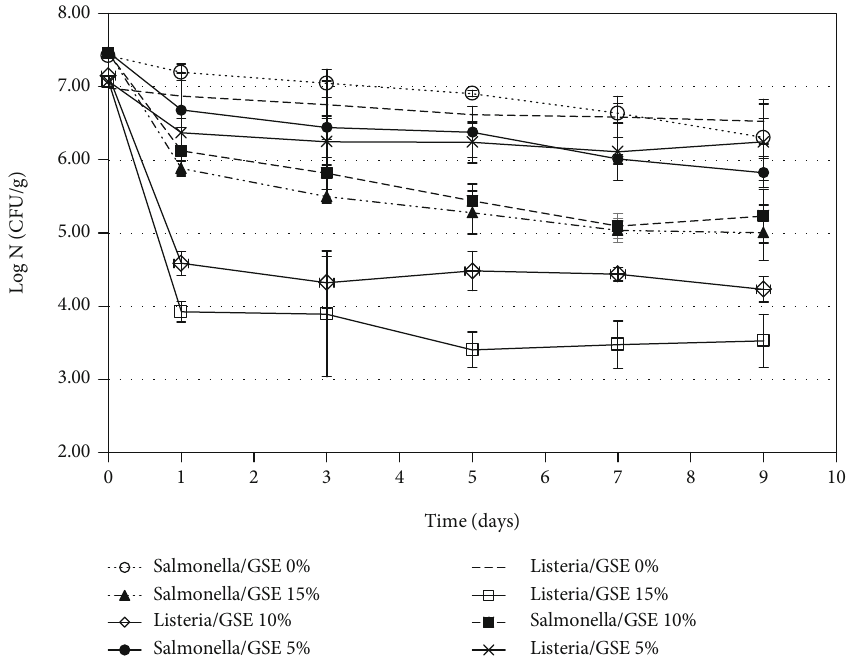
Figure 1: Inhibitory e ff ect of grape seed extract against S. enterica and L. innocua at 25 ° C.